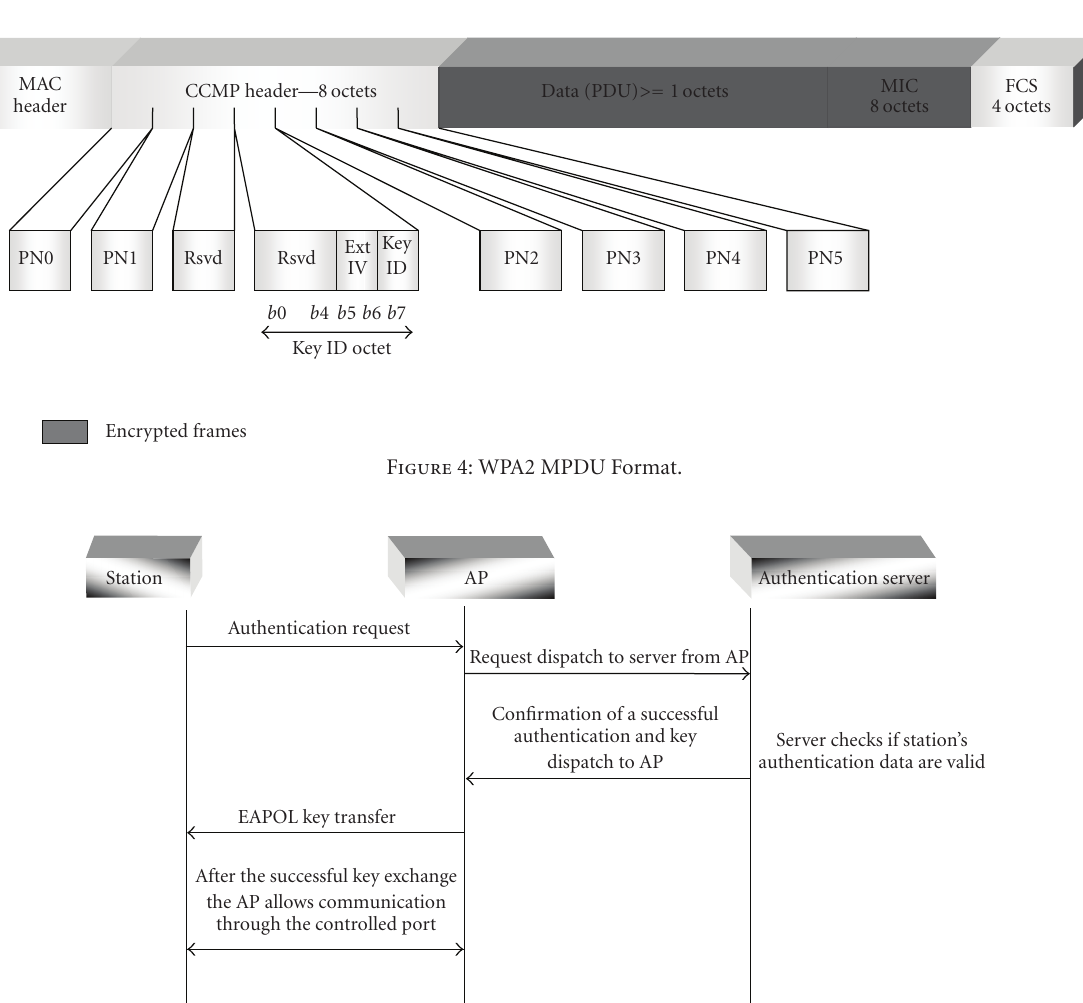
Figure 5: WPA2 Authentication